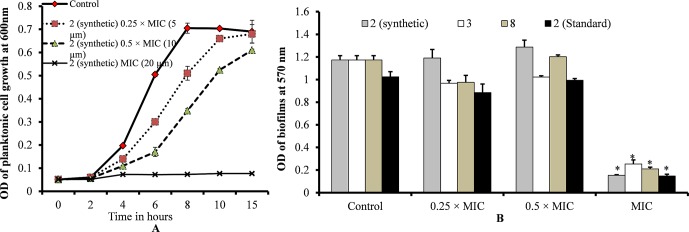

S. pneumoniae planktonic and in vitro biofilm growth in the presence of 0.25 × MIC or 0.5 × MIC or MIC of viniferins. (A) Planktonic growth was detected by measuring observance at 600 nm. (B) Biofilm biomass was detected via CV microplate assay. The error bars represent standard deviations. Statistical significance was calculated via Student’s t-test, and p < 0.05 was considered significant.